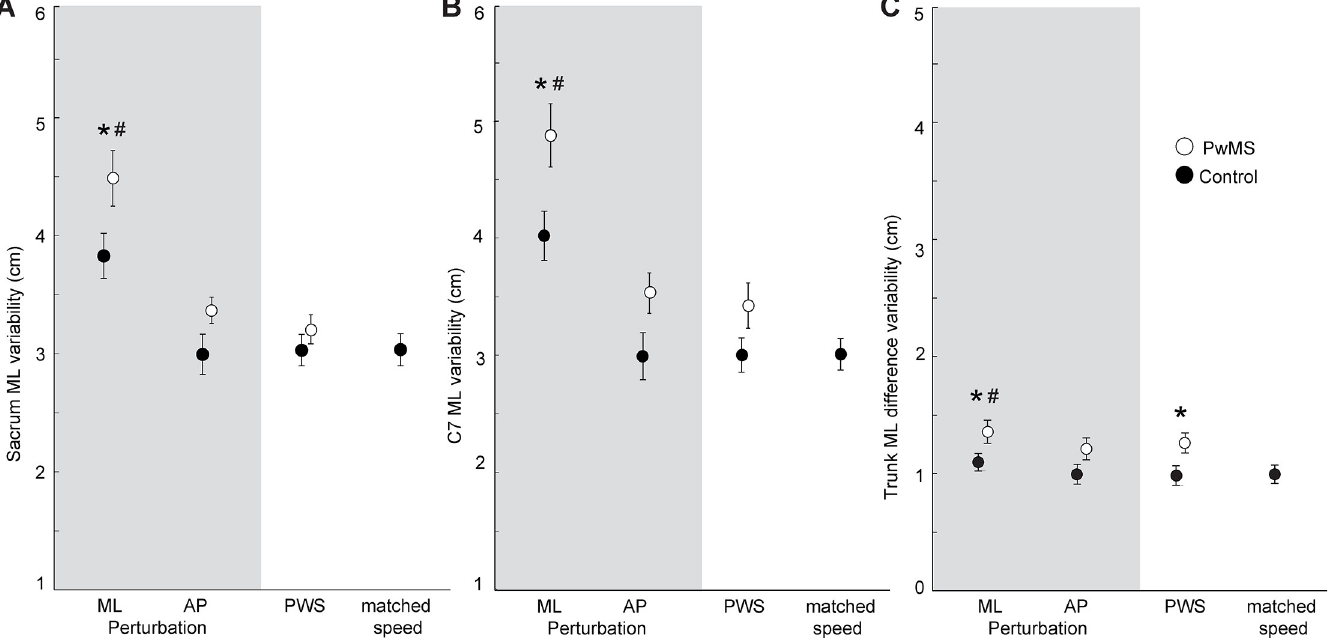
Fig 2. Postural outcomes in PwMS versus age-matched controls across walking tasks. Group average (standard error) mediolateral variability of the sacrum (Panel A), seventh cervical vertebra (Panel B) position, and of the relative difference between sacrum and C7 positions (Panel C) for people with multiple sclerosis (PwMS) and age-matched controls over 1 minute of walking per condition. Conditions include mediolateral (ML) and anterioposterior (AP) optical flow perturbations and two control trials. The PWS and matched speed trials have unperturbed optical flow at the participant’s preferred walking speed and the preferred walking speed of the matched PwMS, respectively. Single asterisks ( � ) denote significant differences (p < 0.05) between PwMS and controls for a given condition. Pound signs (#) denote significant effects (p < 0.05) of perturbations compared to unperturbed walking (PWS) across both